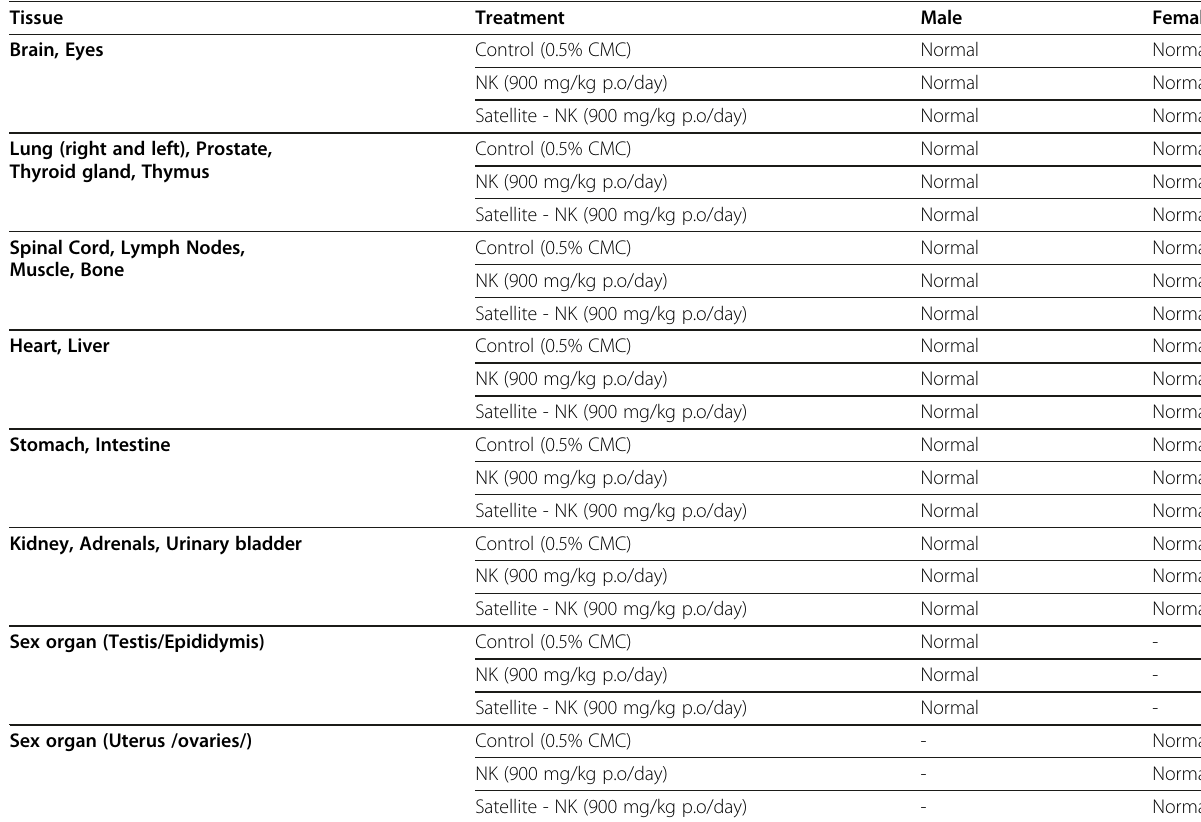
Table 12 Histopathological investigation of control and NK treated animals for 28 days Tissue Treatment Brain, Eyes